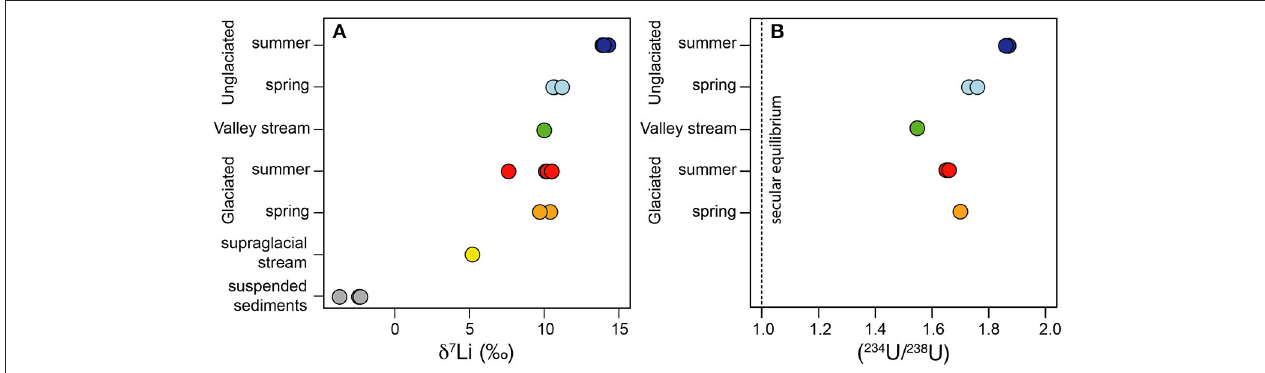
FIGURE 2 | (A) The variation in δ 7 Li values within the water samples. The suspended sediments are shown for comparison and represent the isotopic composition of the initial Li released during chemical weathering. (B) The variation in ( 234 U/ 238 U) values within the water samples. The dashed line indicates where the solids would be if they were in secular equilibrium i.e., when ( 234 U/ 238 U) = 1.